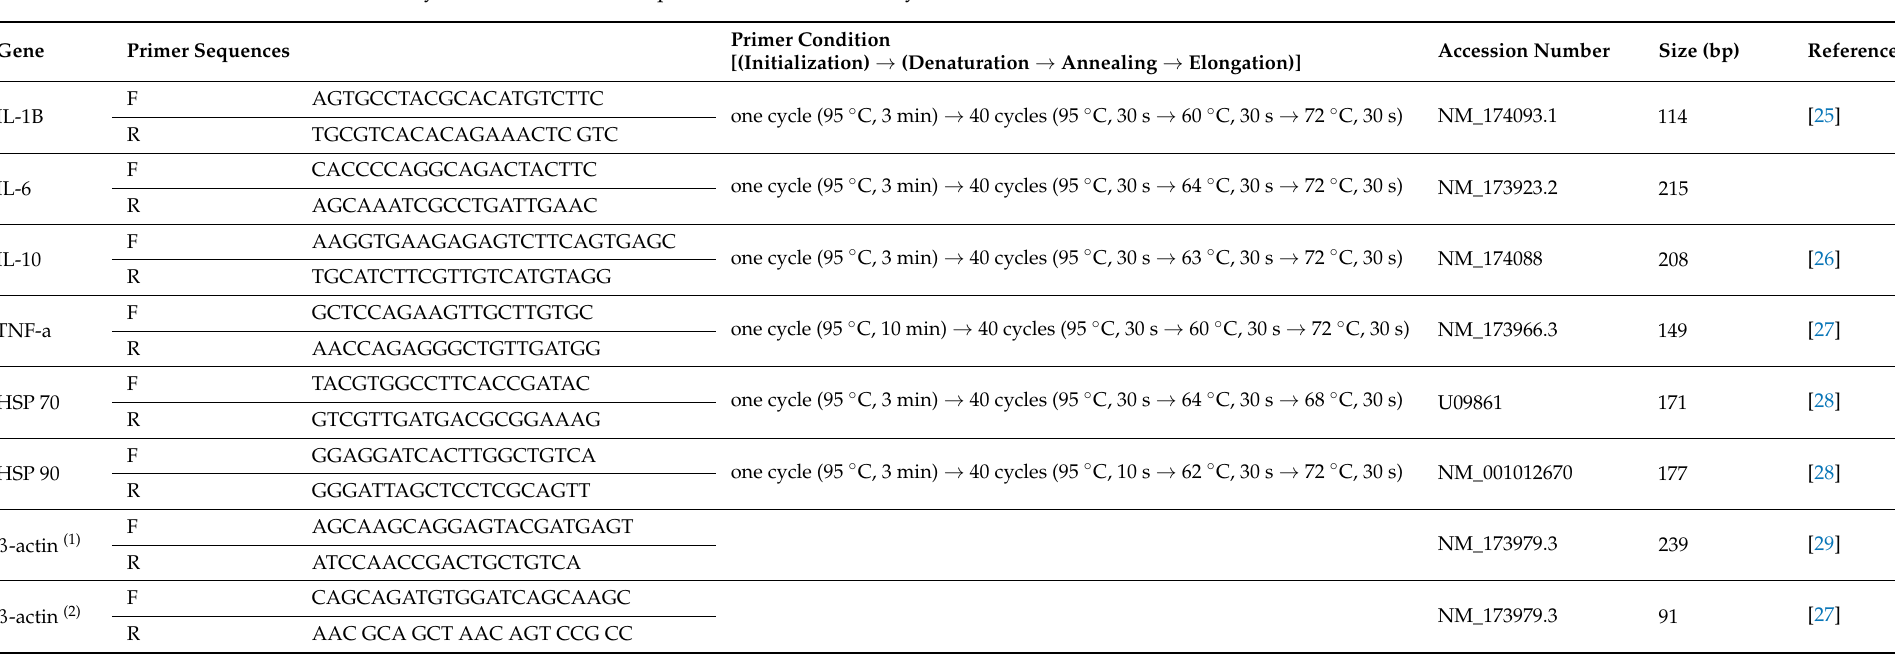
Table 3. Polymerase chain reaction primers used in this